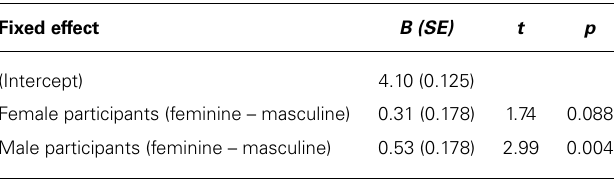
Table 5 | Fixed effect estimates for a rating bias toward feminine morphed faces in Experiment 2.